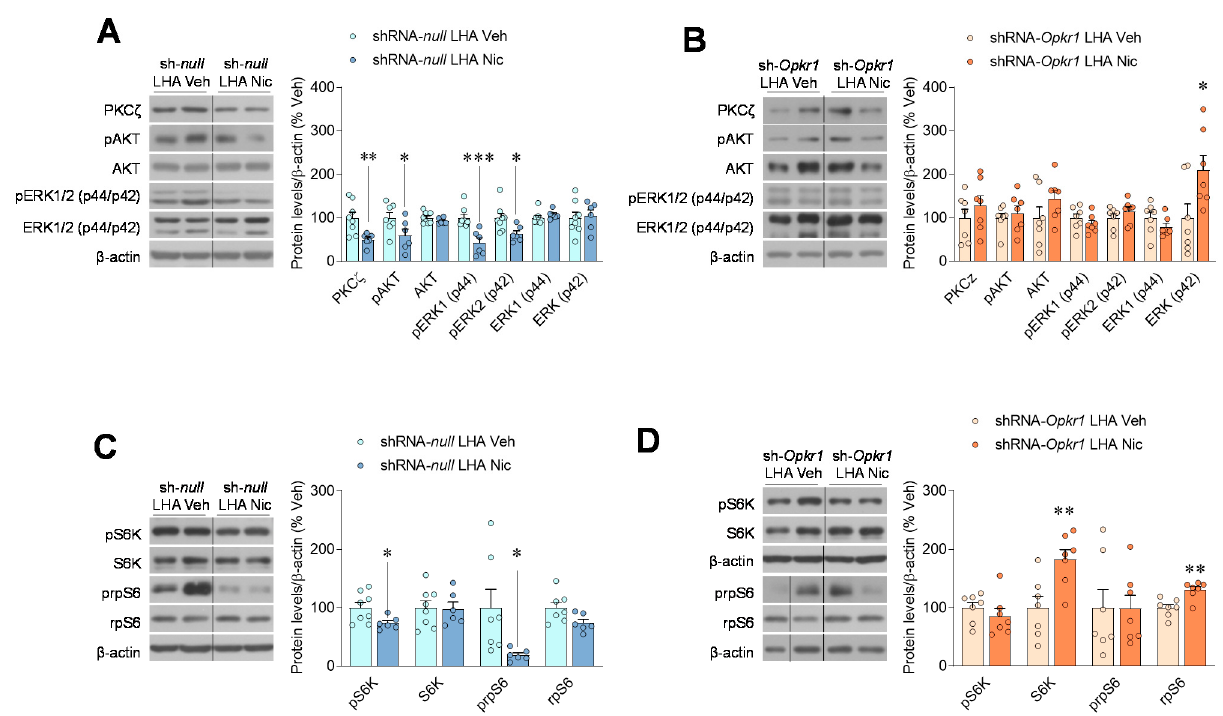
Figure 4. Nicotine inhibits κ OR signaling in the LHA. ( A , B ) Protein levels of κ OR signaling pathways in the LHA ( n = 6–8 rats/group), ( C , D ) protein levels of S6K signaling pathway in the LHA (n= 6-8 rats/group), of rats stereotaxically treated within the LHA with shRNA -null ( A – C ) or shRNA -Opkr1 ( B – D ) adeno-associated viruses and treated SC with vehicle or nicotine through osmotic minipumps for 14 days. * p < 0.05, ** p < 0.01 vs. *** p < 0.001 vehicle. Data are expressed as mean ± SEM. The bands in gels from panels A – D have been spliced from the same original gels.